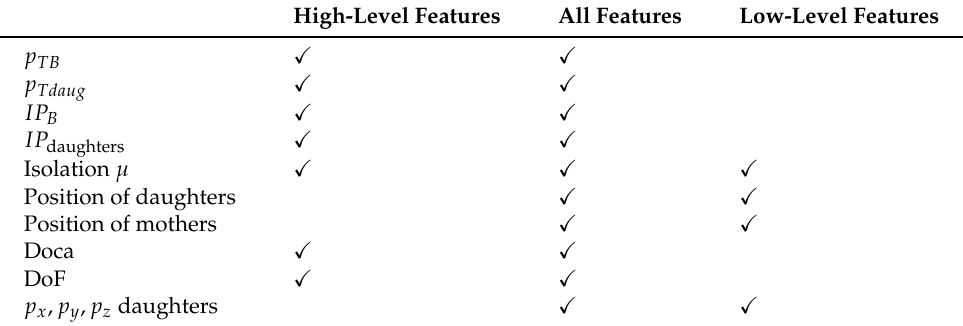
Table A1. Features present in each training option for the data. Note that the isolation only applies µ + µ − channel. to the B →